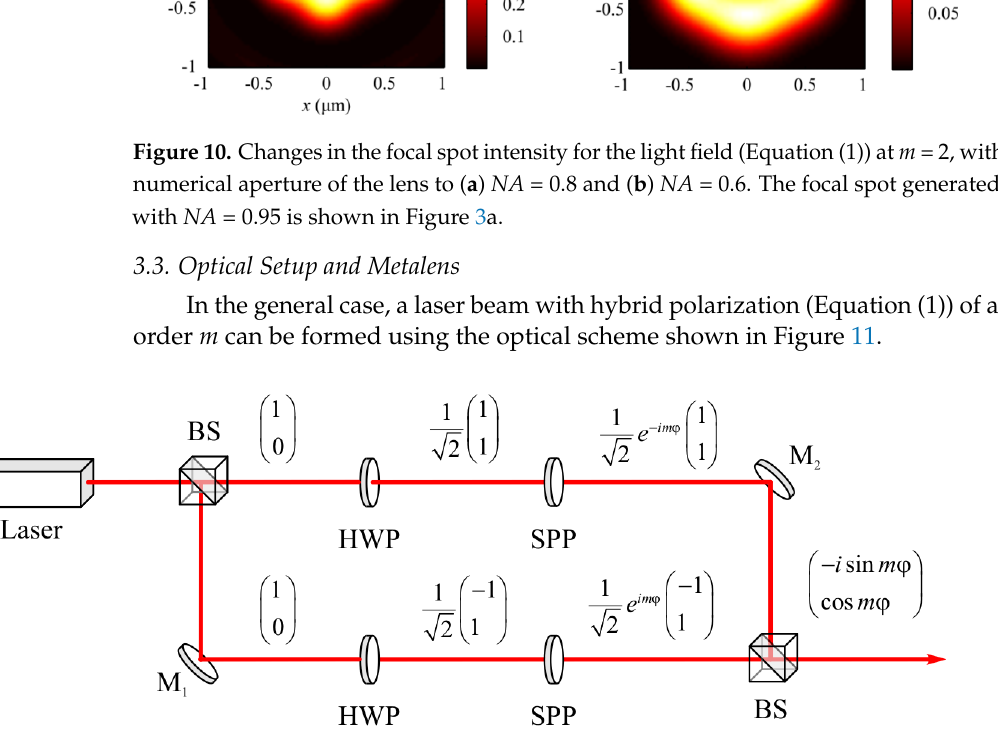
Figure 11. An optical scheme for generating a laser beam with hybrid polarization (Equation (1)) of an arbitrary order m . HWP is a half-wave plate; BS is a beam splitter; M1 and M2 are mirrors; SPP is a spiral phase plate. A linearly polarized light from a laser (Figure 11) is divided by a beam splitter (BS) into two identical beams that propagate in different arms of a Mach–Zehnder interferometer. Two beams with mutually orthogonal polarization are generated after passing through half- wave plates (HWPs) tilted at different angles. Both of these beams pass through the spiral phase plates (SPPs) with transmission functions exp( im ϕ ) and exp( − im ϕ ). These beams are combined into one beam with hybrid polarization (Equation (1)) at the interferometer